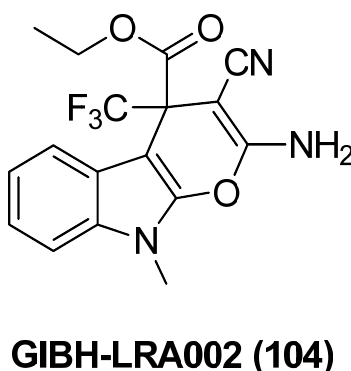
Figure 24. Chemical structure of pyranoindole derivative GIBH-LRA002 ( 104 ).